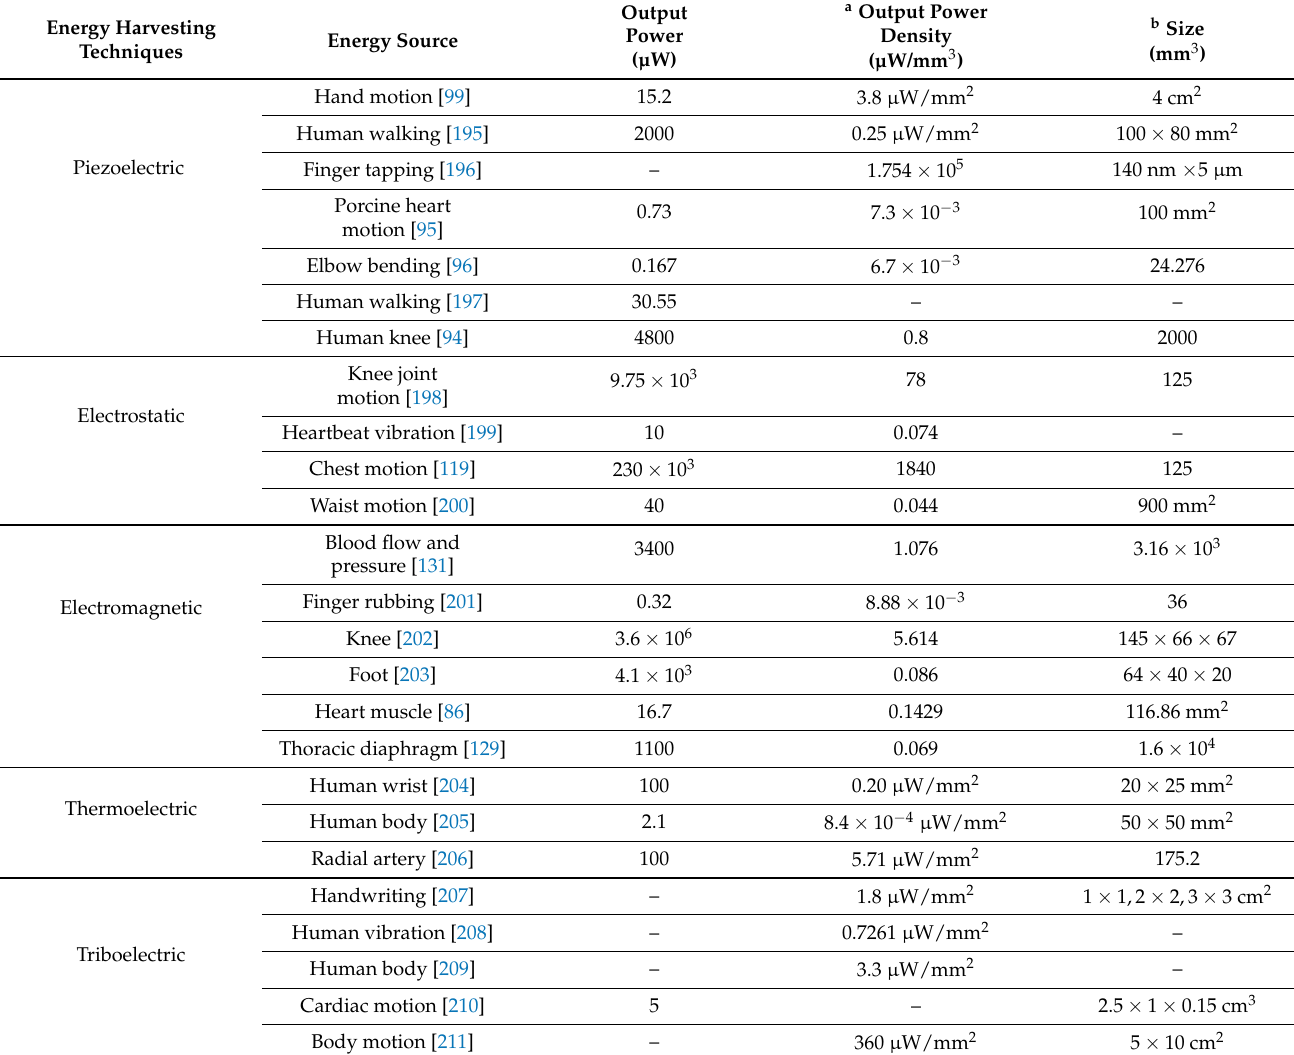
Table 1. Summary of representative research on human-centric biomechanical energy